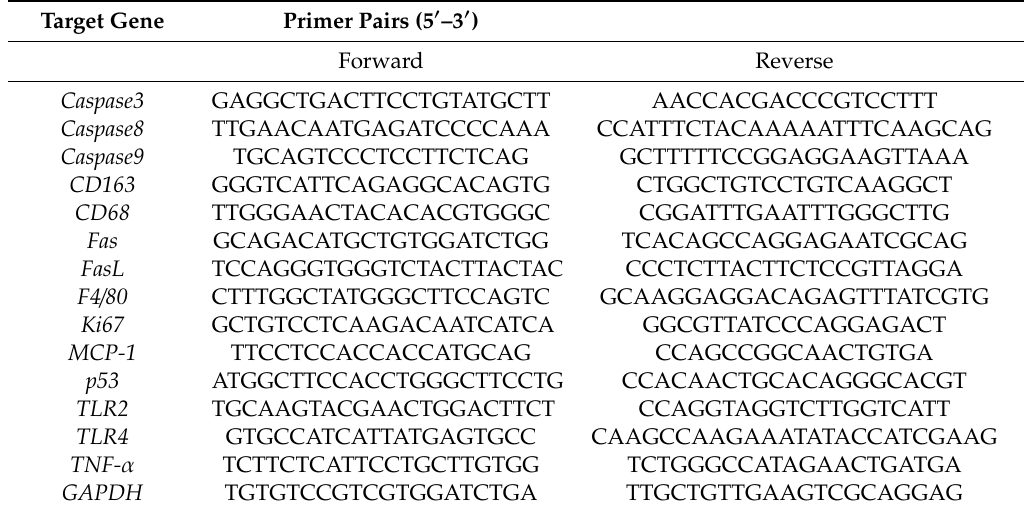
Table 2. Primers used for real-time